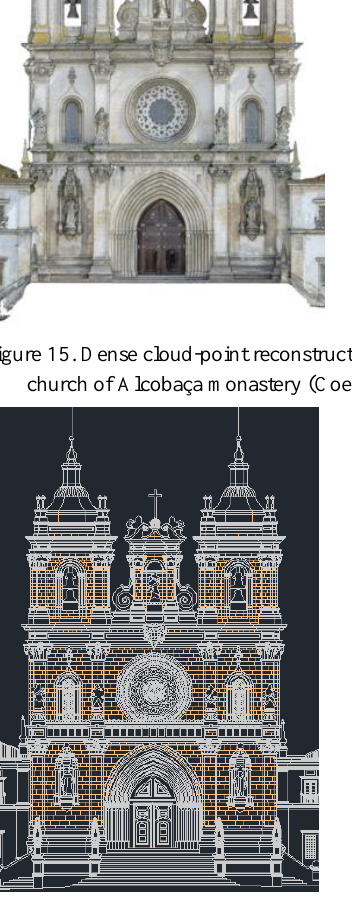
Figure 16. Photogrammetric restitution of the facade of the church of Alcobaça monastery (Coelho, Genin,